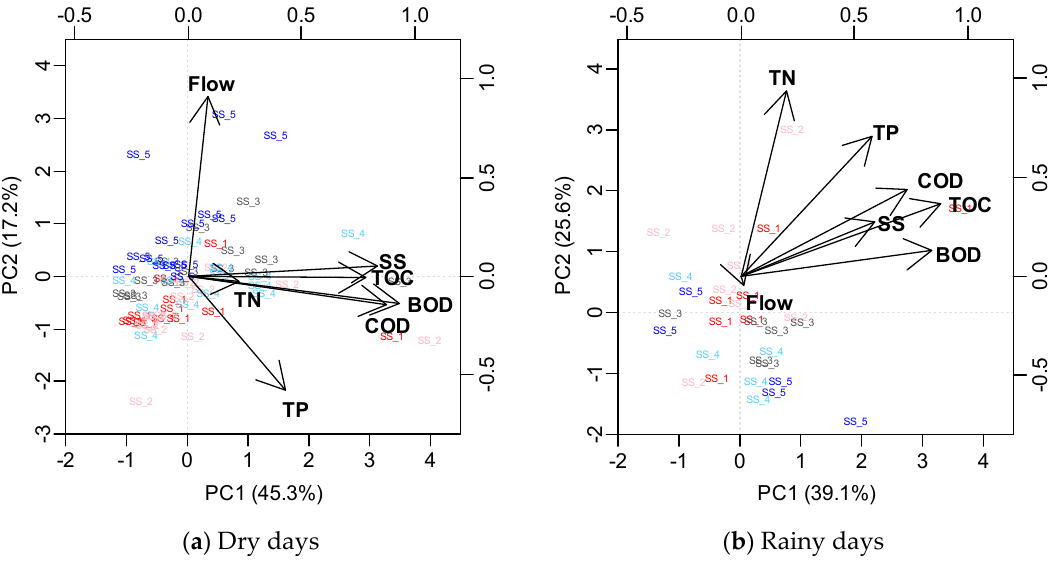
Figure 10. Biplot of principle components for water quality characteristics in Seolseongcheon. Table 6. Loadings of experimental variables (7) on principal components for three watersheds.